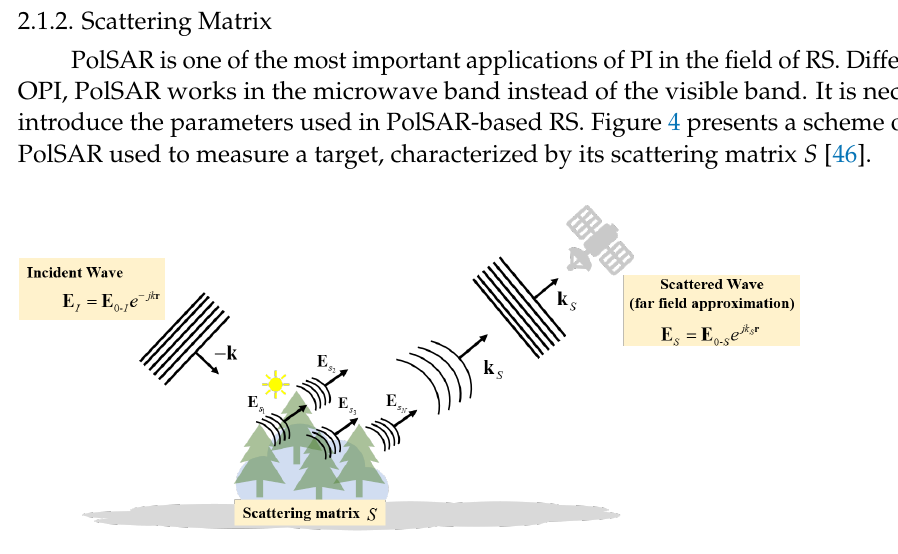
Figure 4. Interaction of electromagnetic wave and